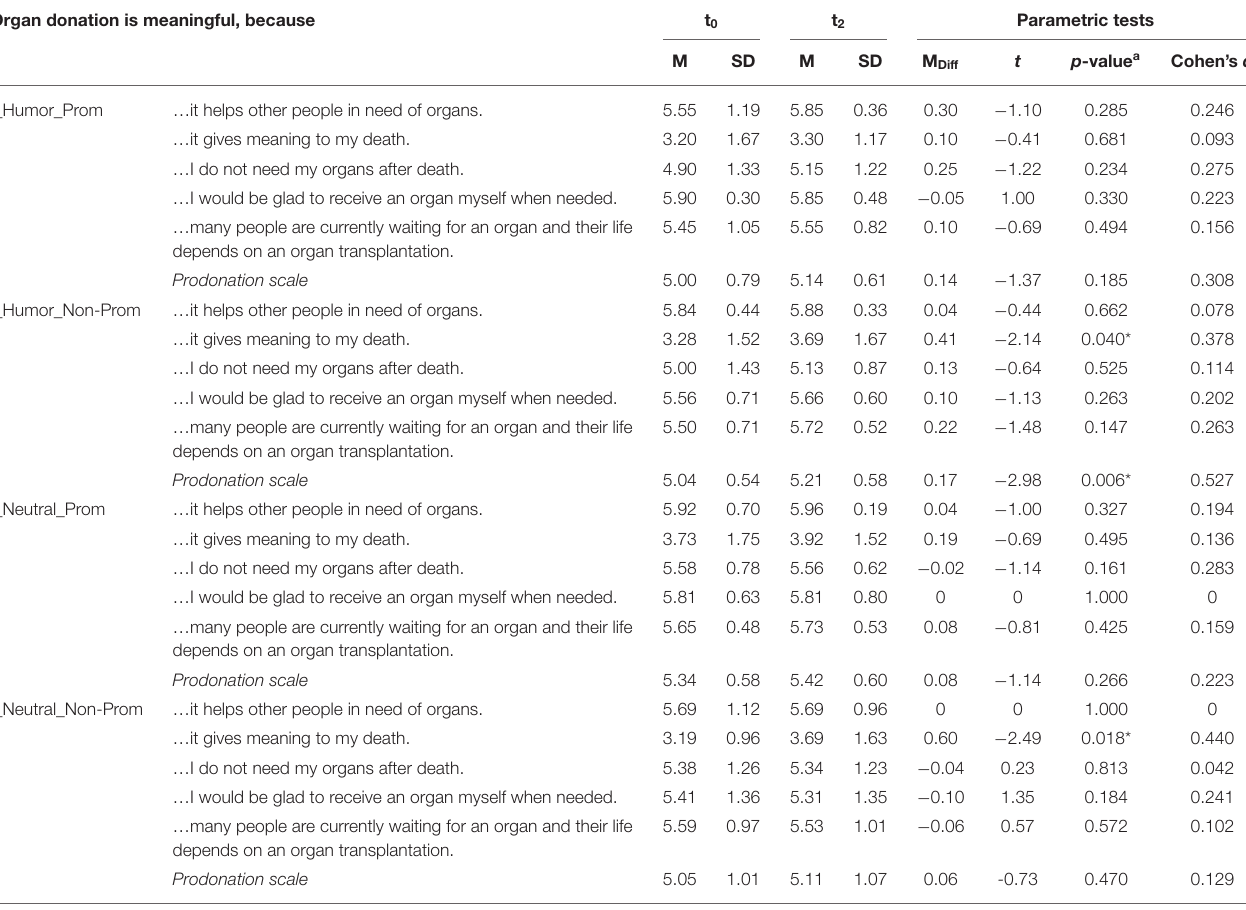
TABLE 2 | Prodonation items at t 0 and t 2 ( n =